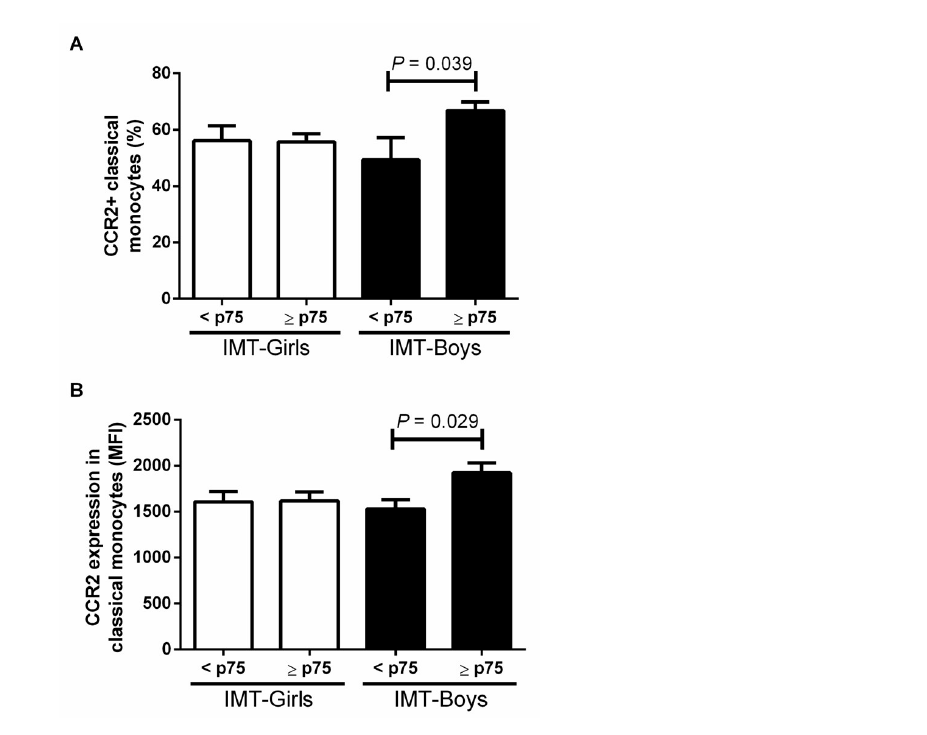
Figure 2. Evaluation of ( A ) the proportion of CCR2 in classical monocytes and intima media thickness (IMT) and ( B ) expression of CCR2 in classical monocytes and intima media thickness (IMT) by sex. We considered a high-risk IMT ≥ p75 and compared differences by the student T -test, considering a p value < 0.05 as significant. The intermediate monocyte subpopulation displayed similar behavior, where the CCR2 + cell percentage was 50 ± 36.7% higher in male children with IMT ≥ p75 than in boys with IMT below the p75 ( p = 0.044). The CCR2 expression was 16.1% ± 6.5% higher in intermediate monocytes from boys with IMT ≥ p75 than in male children without subclin- ical atherosclerosis risk ( p = 0.047) (Figure 3).